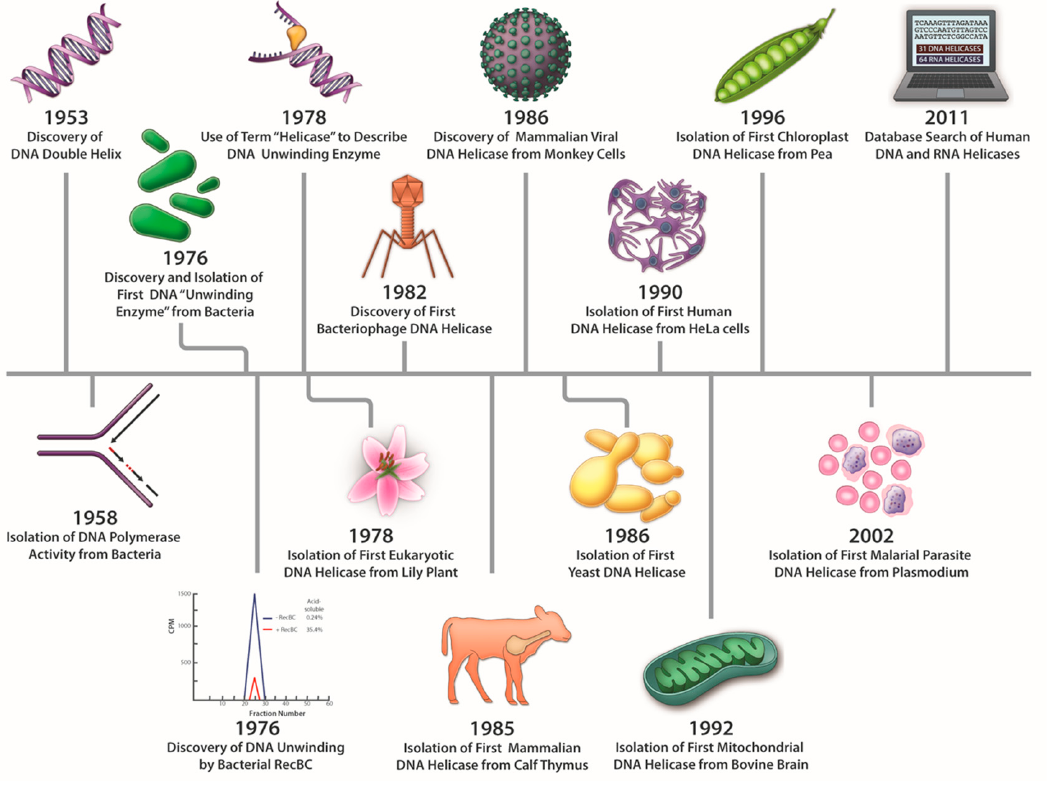
Figure 1. Timeline for discovery of prokaryotic, eukaryotic, and viral DNA helicases. See references and text for details. 1953, Discovery of DNA double helix [16] ; 1958, Discovery of DNA polymerase I [17,18] ; 1976, Discovery of first bacterial DNA unwinding enzyme [1–3]; 1978, “Helicase” term coined [6,7]; 1978, First eukaryotic DNA helicase [19] ; 1982, First bacteriophage helicase [20] ; 1985, First mammalian DNA helicase [21] ; 1986, First mammalian viral DNA helicase [22] ; 1986, First yeast DNA